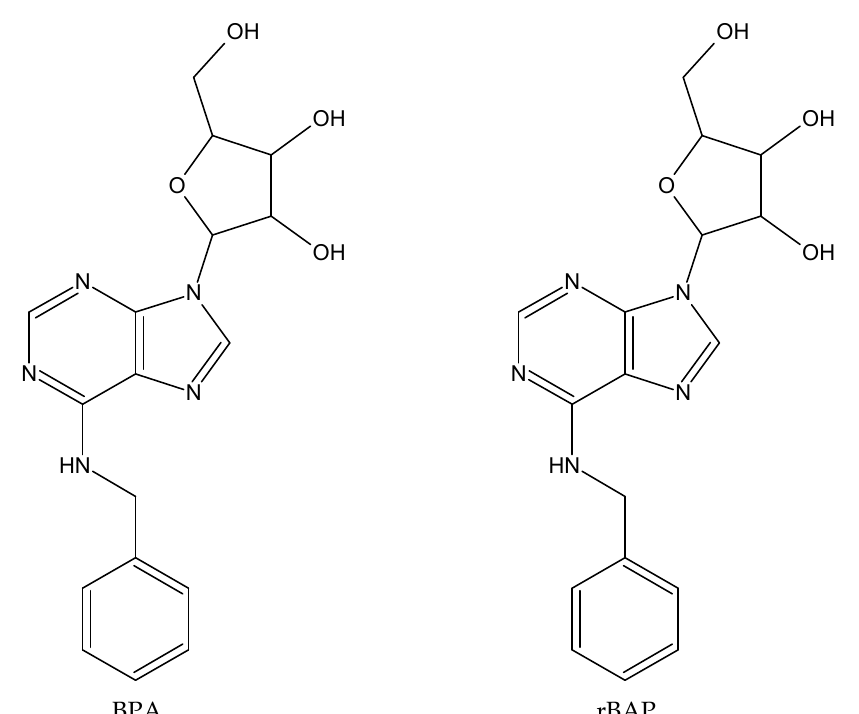
Figure 1. Chemical structures of purine-type cytokinin used in the study.